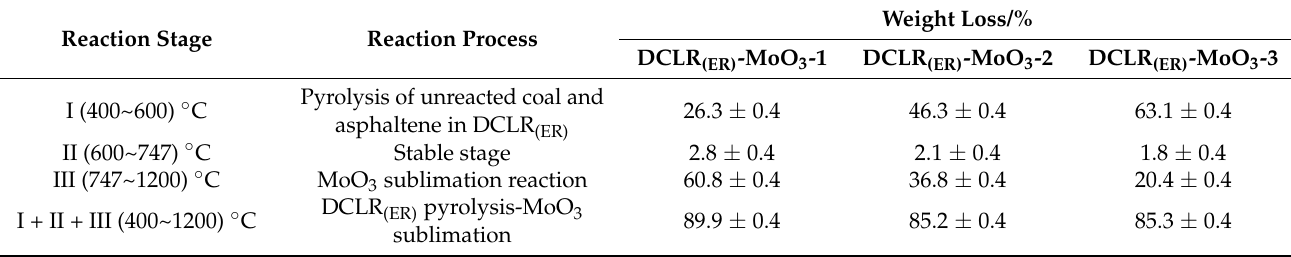
Table 1. Results of DCLR (ER) -MoO 3 thermal analysis with different mass